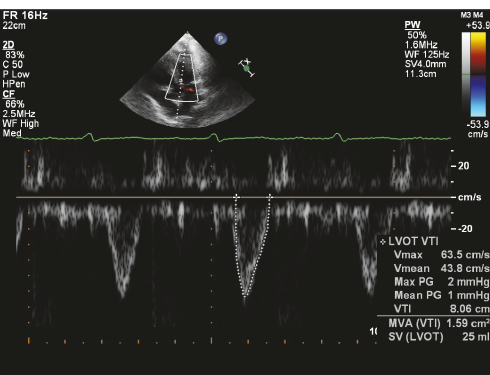
Figure 3: At the time of clinical deterioration, pulse Doppler of the LVOT and continuity equation calculated SV/CO (LVOT dimension-